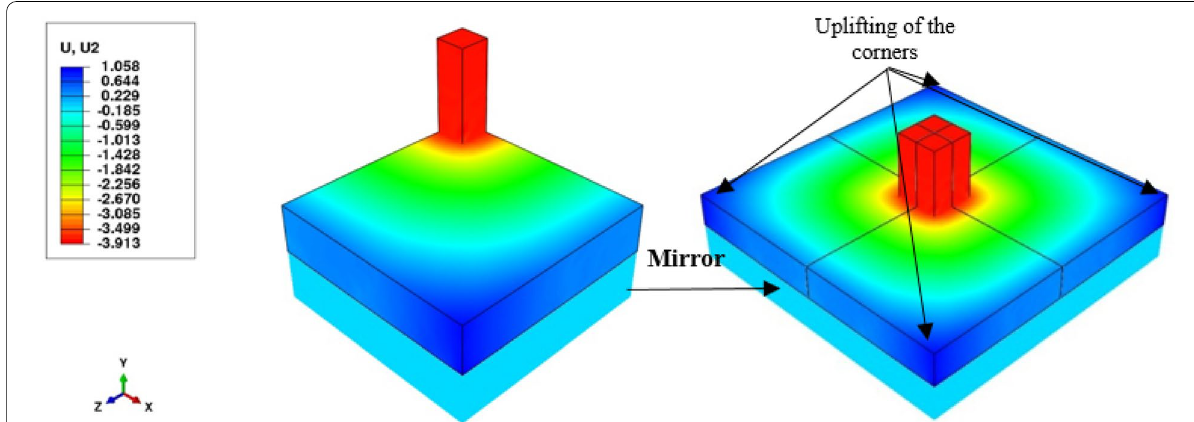
Fig. 19 Deflection shape at failure load.